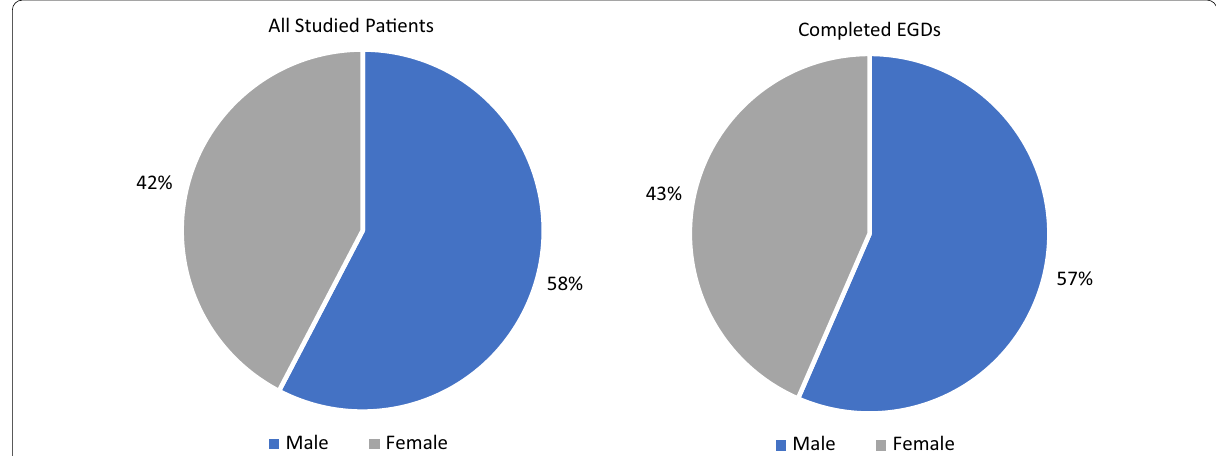
Fig. 2 Breakdown of sex and rate of EGD completion. There was a total of 111 studied patients. Of those 64 were male and 47 females. Sixty-nine (62.2%) total participants completed their screening. Of those 30 (63.8%) were female and 39 (60.9%) were male. There was no significant difference found comparing sex to EGD completion rate